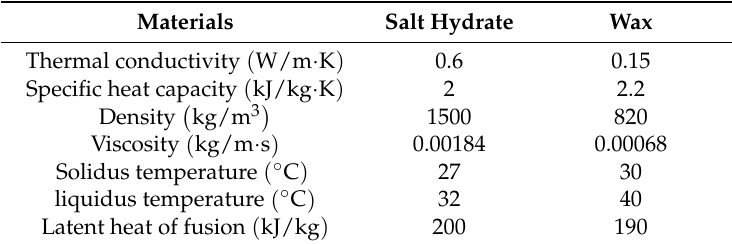
Table 1. Thermo-physical properties of the Phase Change Materials (PCMs)